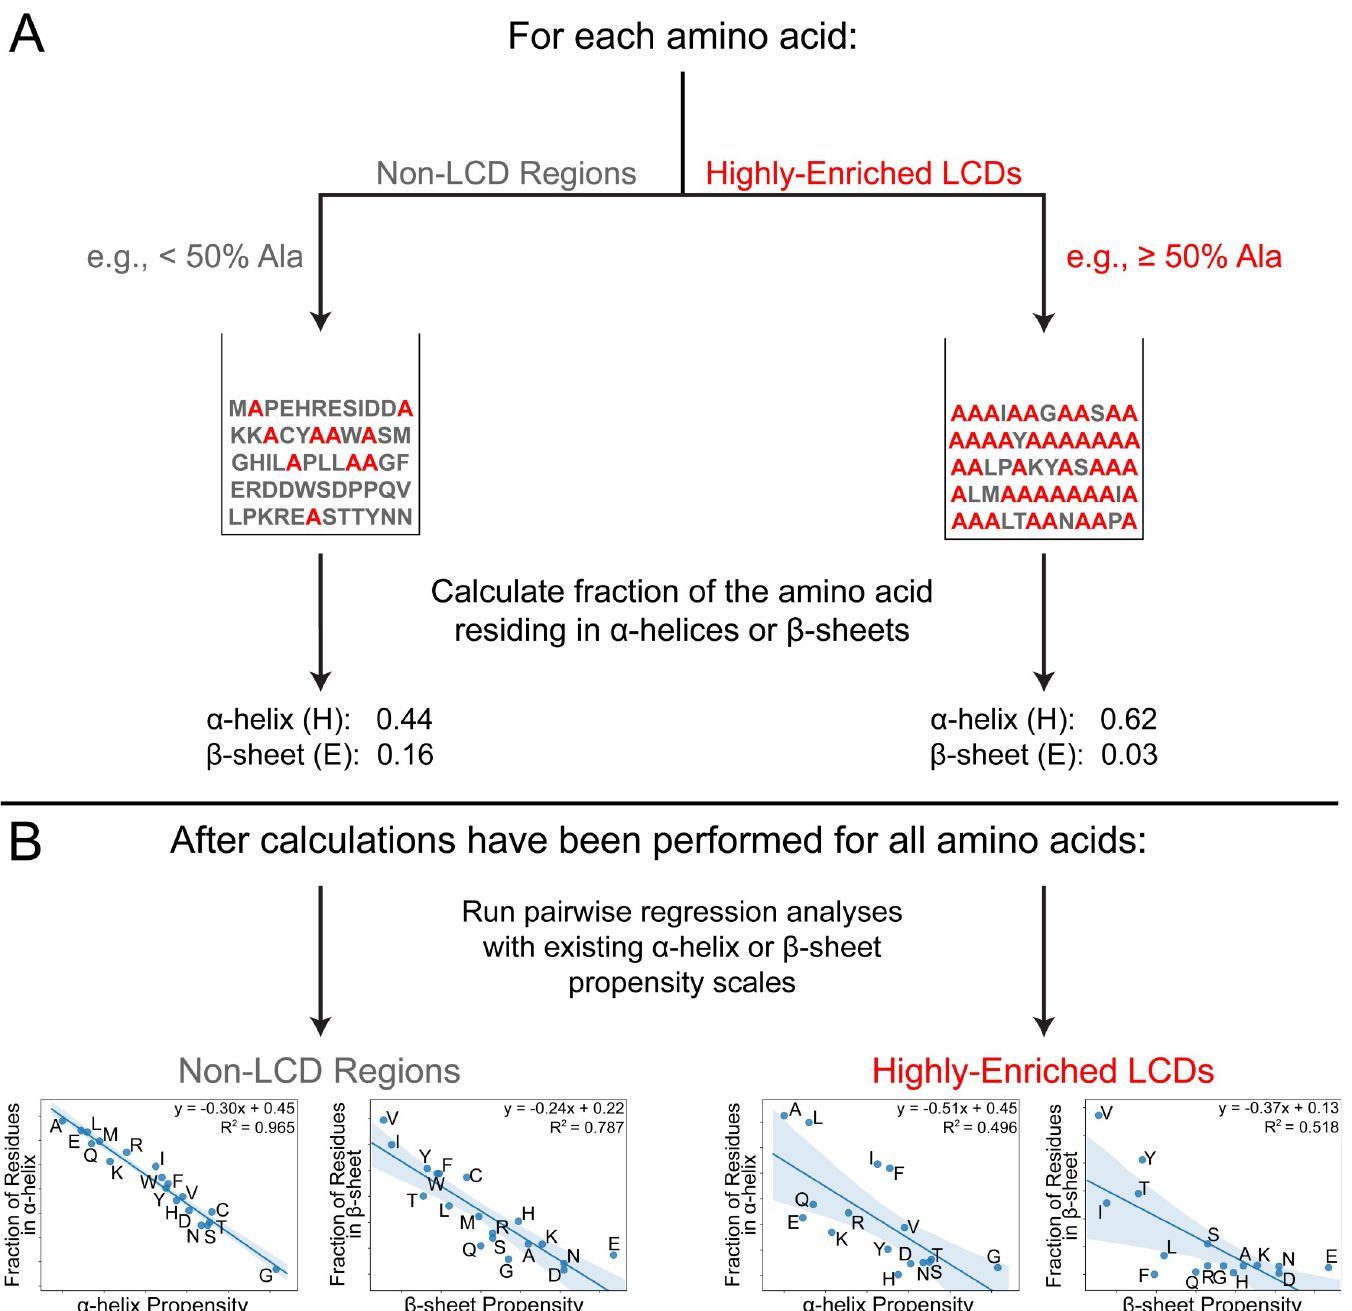
Fig 6. Computational strategy for assessing the efficacy of established secondary structure propensity scales in predicting secondary structure tendencies among LCDs and non-LCD regions. (A) For each amino acid, the PDB proteome is scanned using a 12aa window, and all windows are parsed into either a “highly-enriched LCD” category (windows with � 50% composition of that amino acid) or a “non-LCD” category (in this context, defined as windows with < 50% composition of that amino acid). For both categories, the fraction of that amino acid annotated as α -helix and the fraction annotated as β -sheet are calculated. This procedure is repeated for all 20 canonical amino acids. (B) Then, pairwise regression analyses are performed between the fraction of residues in α -helices and each of the α -helix propensity scales. To determine how well secondary structure propensity scales apply to LCD and non-LCD regions, regression analyses are performed separately for “highly-enriched LCDs” and the “non-LCD” category. This process is repeated for the fraction of residues in β -sheets and each of the β -sheet propensity scales. In regression analyses, missing amino acids indicate that the amino acid was removed from analyses either because few of the established secondary structure propensity scales scored that amino acid or, in the case of highly-enriched LCDs, that few LCDs with � 50% of that amino acid exist in the PDB (see Methods).